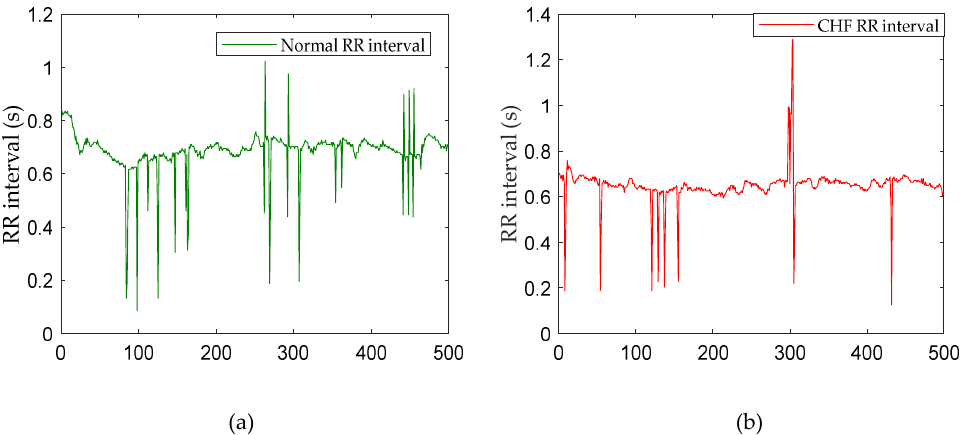
Figure 2. Signals of different type for 500 samples length. ( a ) The normal RR interval. ( b ) The congestive heart failure (CHF)-RR interval.